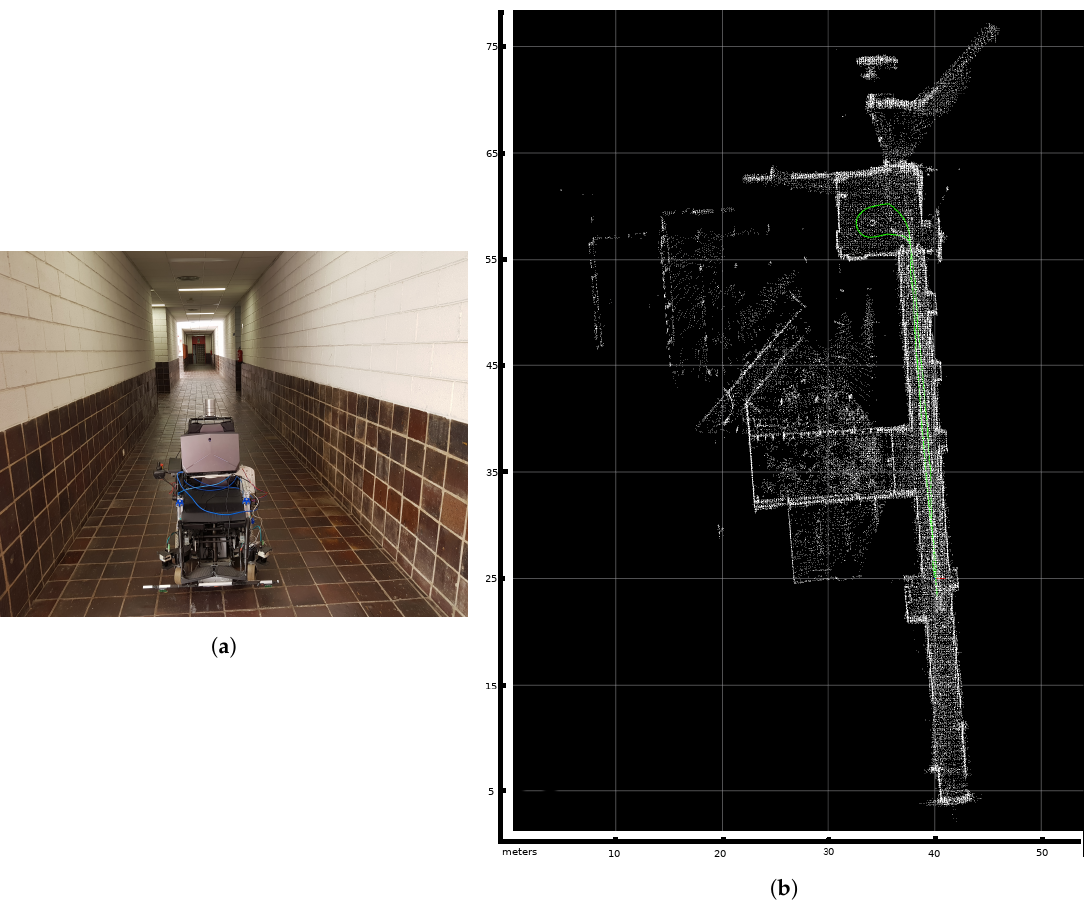
Figure 3. The tests are conducted in a long corridor with a turnaround area at the end. ( a ) The wheelchair in the corridor where the tests are carried out with the Velodyne lidar installed. ( b ) The test area and the path traveled by the wheelchair (green line). Each square of the grid represents 10